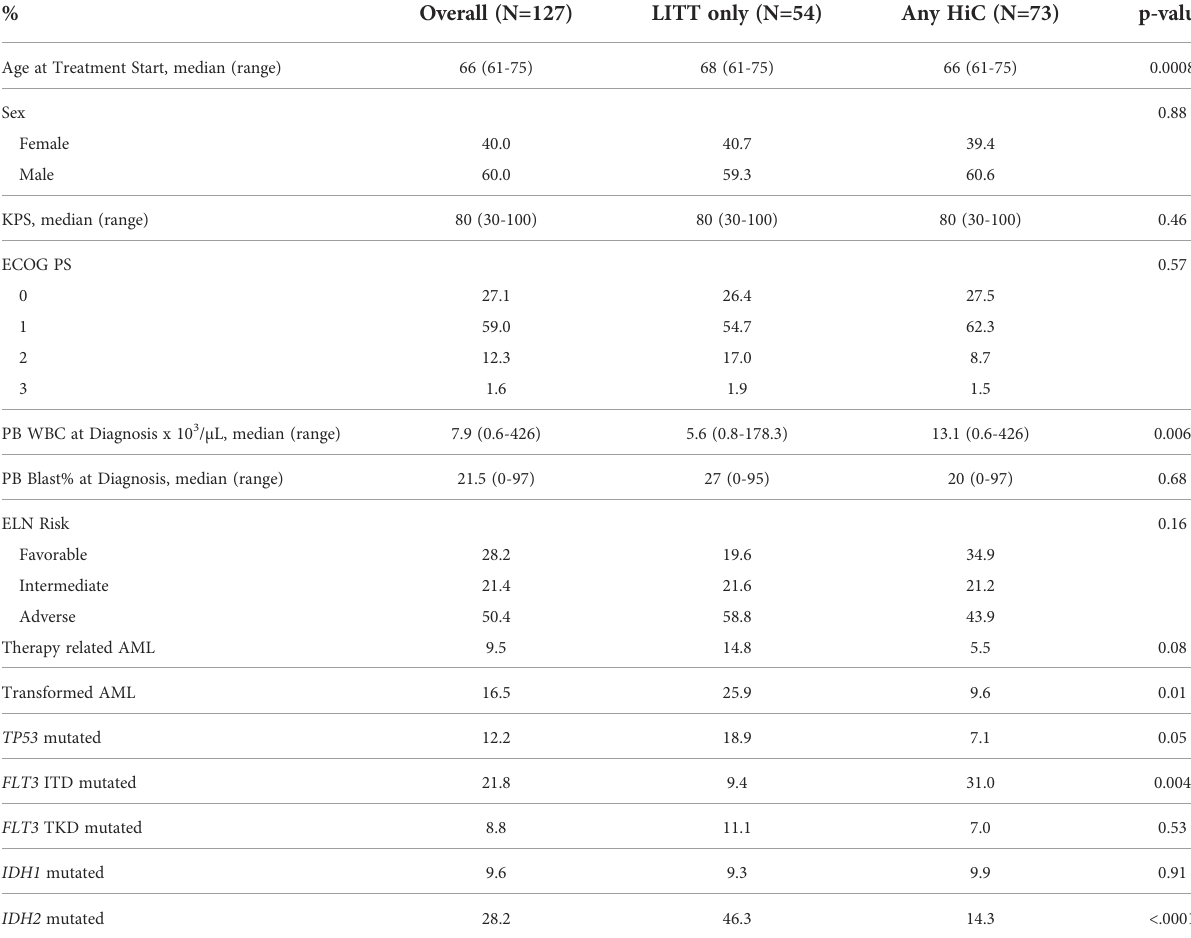
TABLE 1 Baseline patient characteristics according to treatment group.